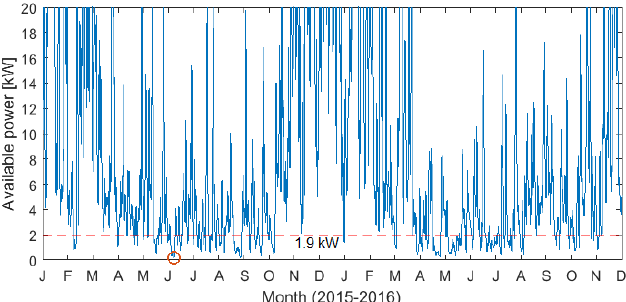
Figure 10. Wave power potential (in W) near Wave Hub (Lat: 50.375; Lon: − 5.625) during 2015 and 2016. The red dashed line indicates the average power of the sea state that is needed for the small WEC to generate 37.7 W of electricity. The red circle indicates the least energetic sea state over the studied